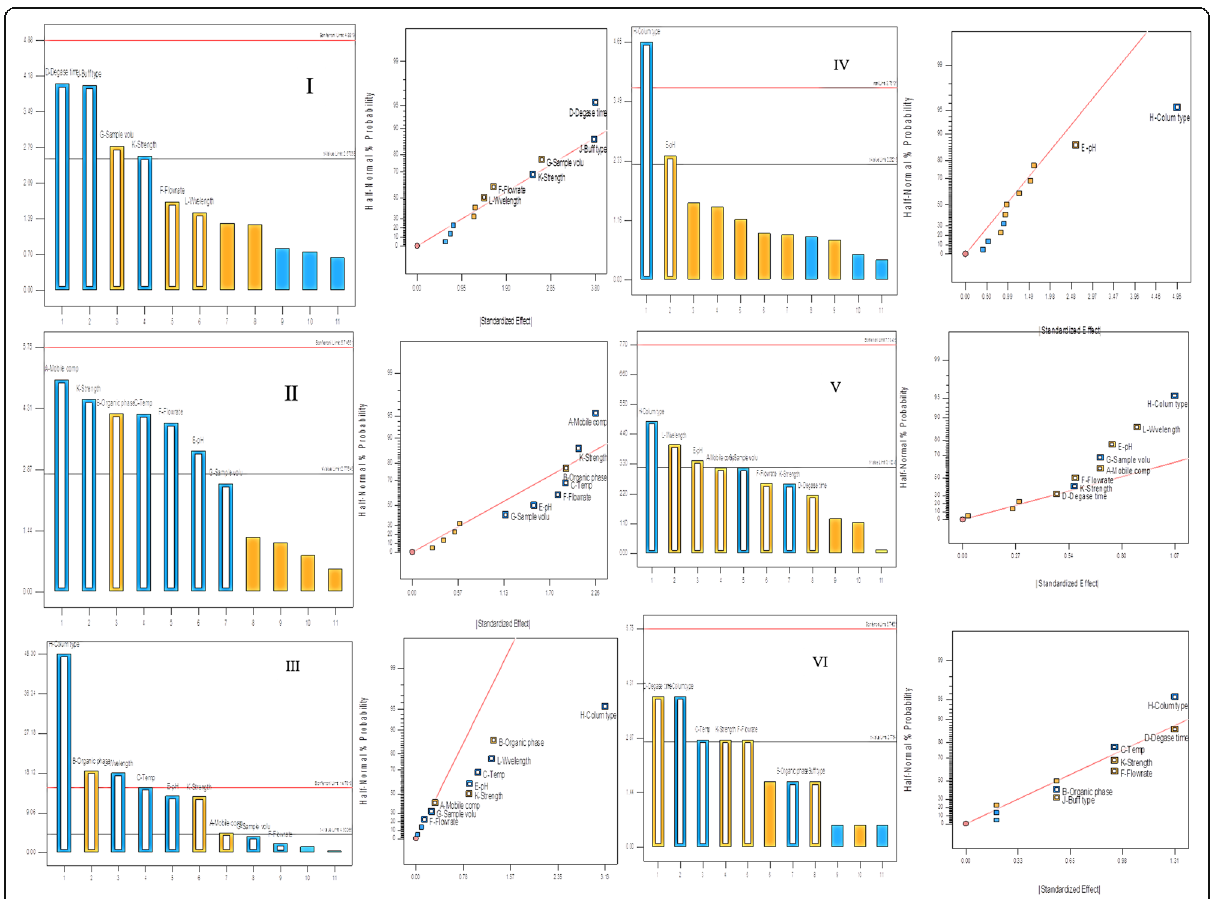
Fig. 4 Pareto and half-normal plots for stability method of